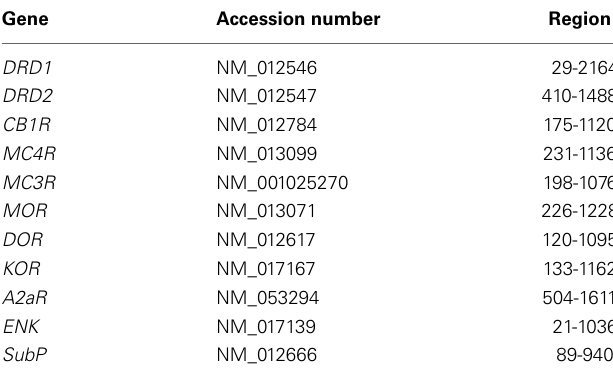
Table 1 | Regions and accession numbers used for synthesis of the FISH